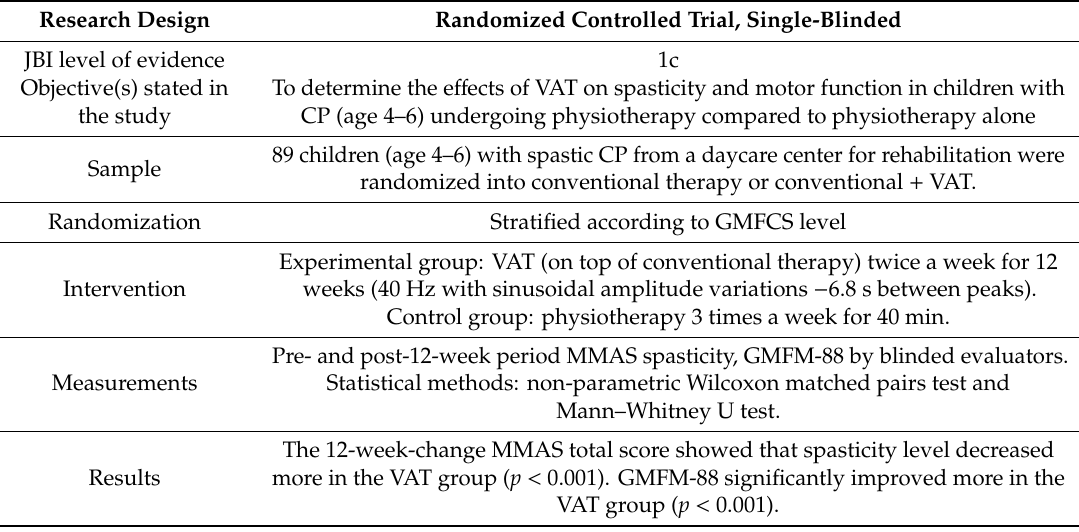
Table 3. Studies on children with CP—Katusic, Alimovic, and Mejaski-Bosnjak [39]. Research